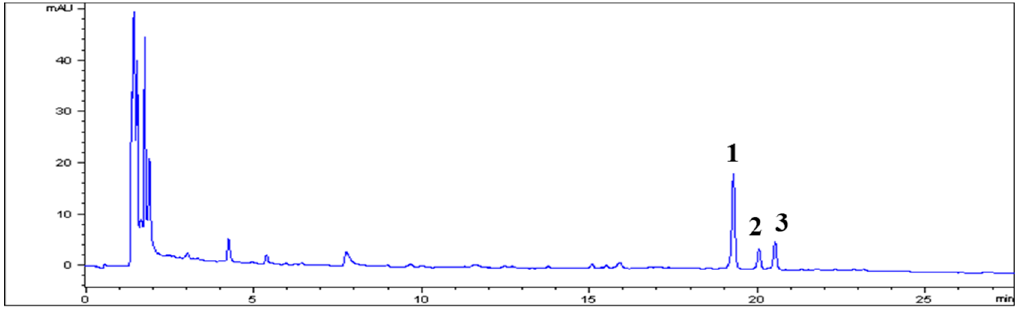
Figure 1. HPLC chromatogram of Achyranthis radix extract (ARE). Peak identification: 1, ecdysterone; 2, 25 R -inokosterone; 3, 25 S -inokosterone. Chromatographic conditions are described in the text. Detection was at 250 nm.